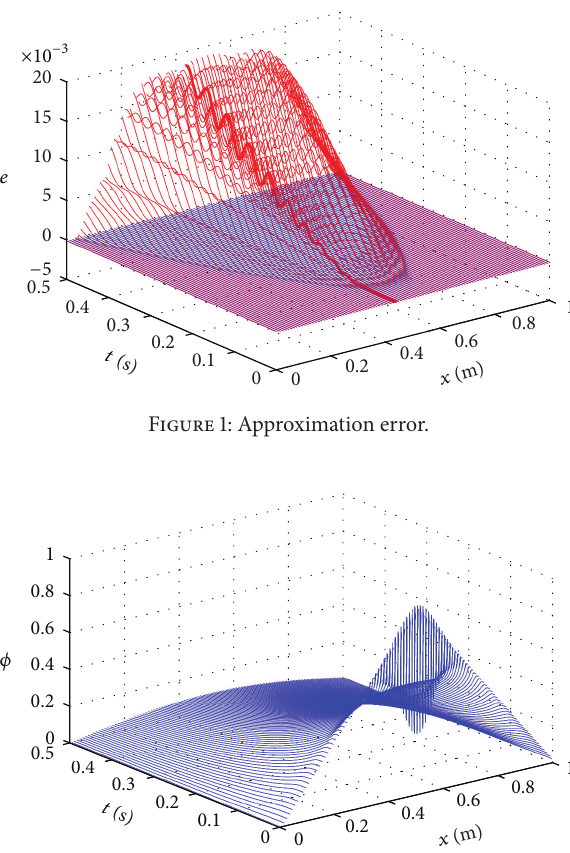
Figure 2: Control